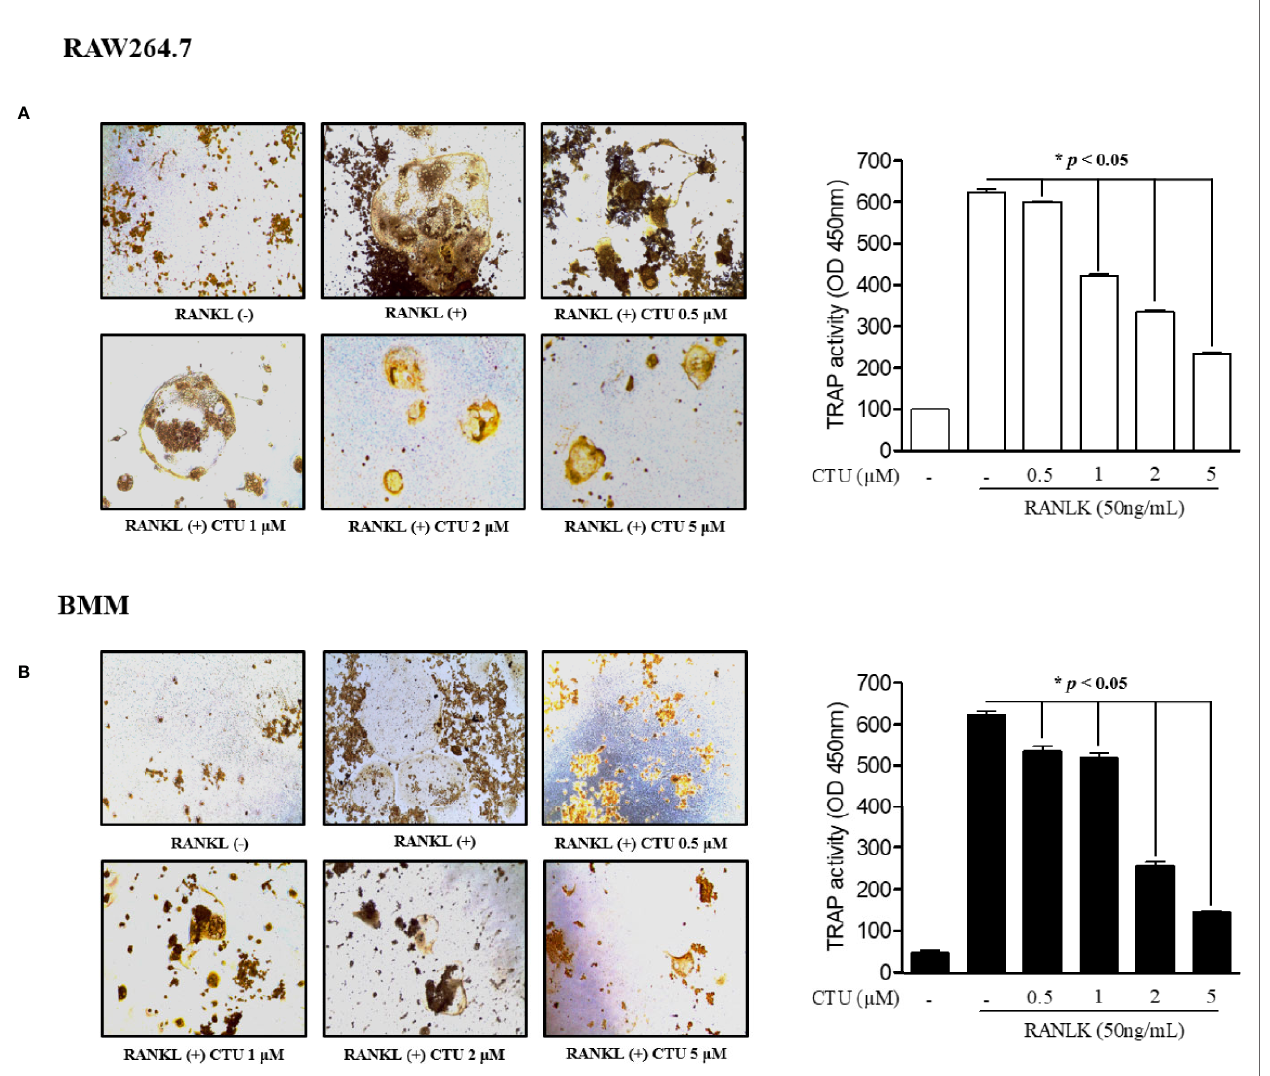
FIGURE 2 | The effect of CTU on osteoclast differentiation in RANKL-induced RAW 264.7 (A) and BMM (B) cells. The cells were incubated with 50 ng/ml RANKL or both RANKL and various concentrations of CTU for 5 days and then stained for TRAP. TRAP activity was measured using an ELISA reader (optical density, 405 nm). * p < 0.05 compared with the only RANKL-treated